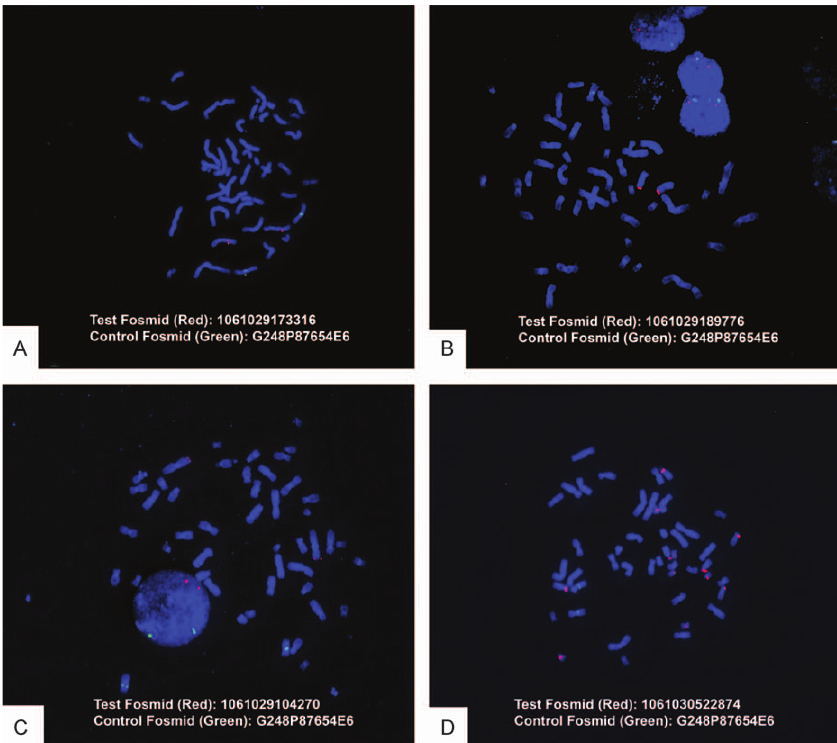
Figure 10. Non-Mapped HuRef Sequences Mapped to Coriell DNA Samples by FISH Sequences from the HuRef donor that had no match based on the one-to-one mapping or BLAST when compared to the NCBI Human reference genome were tested by FISH. Fosmids were used as probes and the experiments were run, using Coriell DNA, to confirm the localization of the contigs or to map contigs with no prior mapping information. Shown here are four representative results. (A) An insertion at 7q22 where the FISH confirmed the HuRef mapping, (B) FISH result confirming the mapping of a sequence extending into a gap at 1p21. (C) Localization of a contig with no prior mapping information to chromosomal band 1q42. (D) An example of euchromatic-like sequence with no prior mapping information, which hybridizes to multiple centromeric